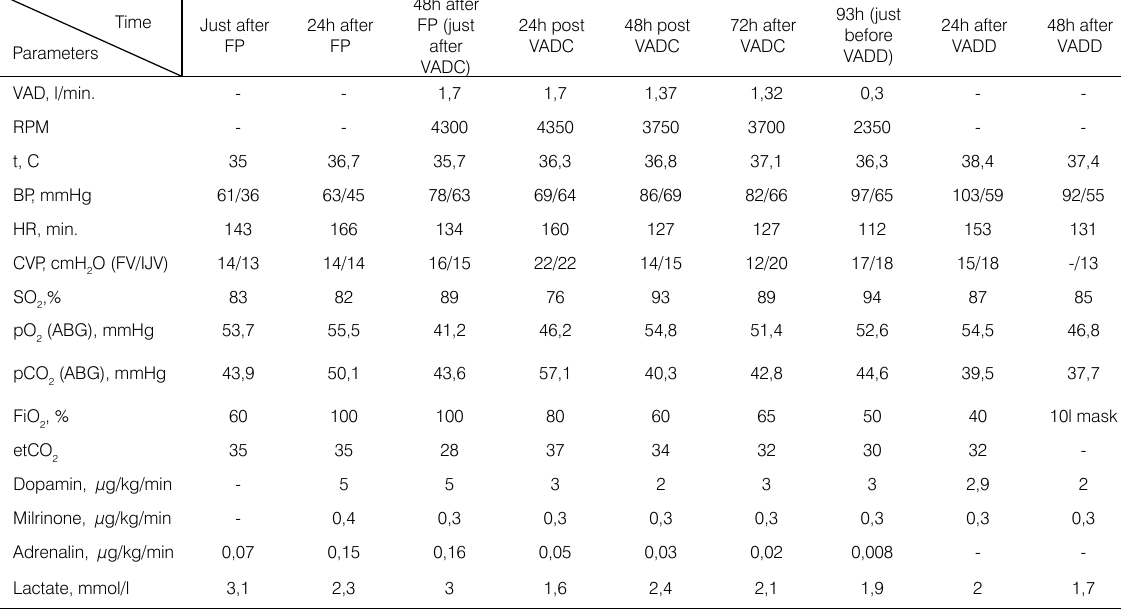
Table 1. Dynamics of PediVAS parameters, dosage of inotropes, arterial blood gas and saturation values in acute phase.